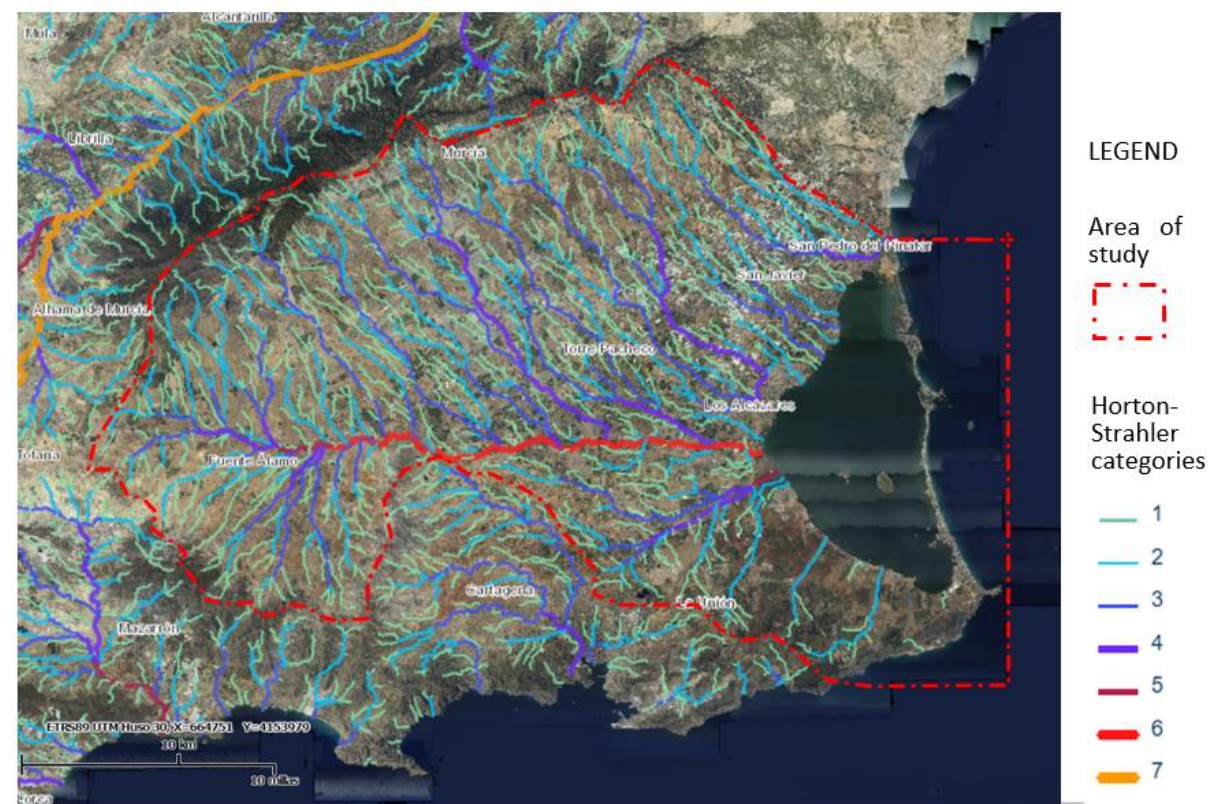
Figure 7. Area of study selected following a watershed model based on Horton–Strahler criteria established by national regulations.